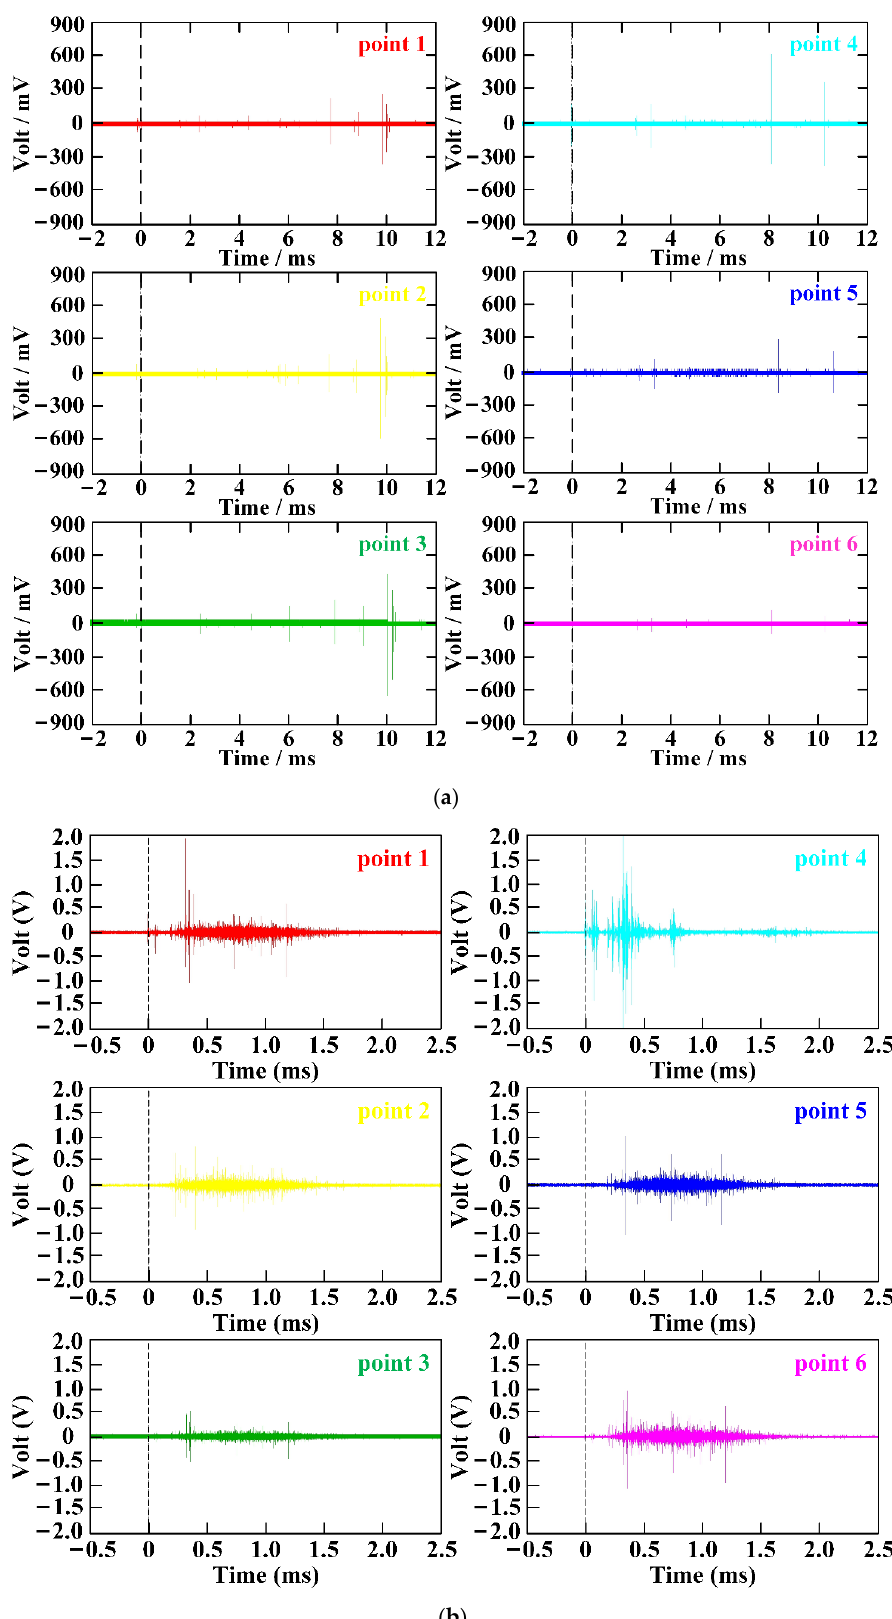
Figure 5. Electromagnetic radiation of TNT explosion. ( a ) Electromagnetic radiation of 30 kg TNT; ( b ) electromagnetic radiation of 60 kg TNT.